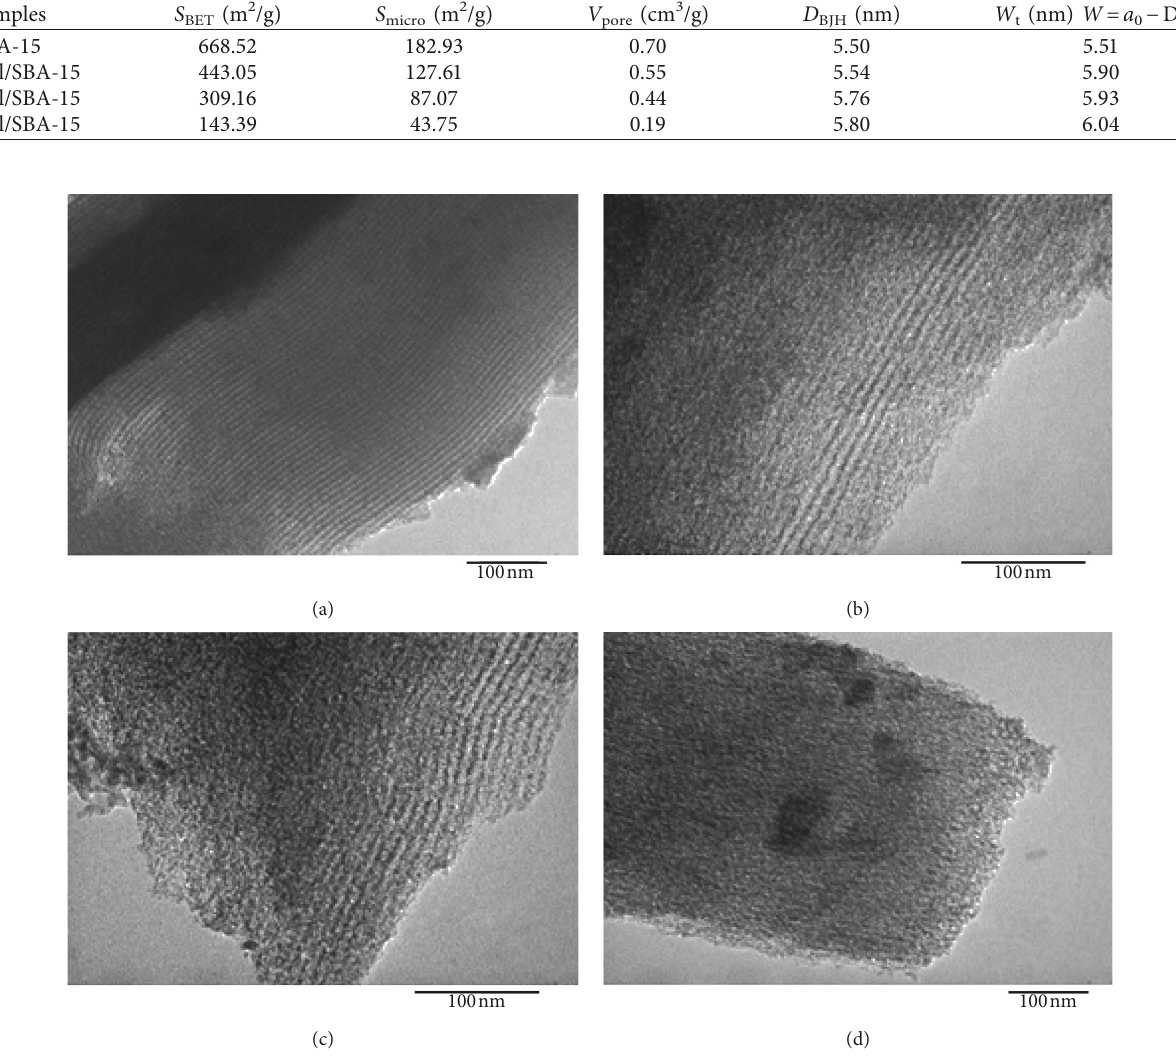
Figure 3: TEM images of (a) SBA-15 and (b) xAl/SBA-15, (c) xAl/SBA-15, and (d) xAl/SBA-15.